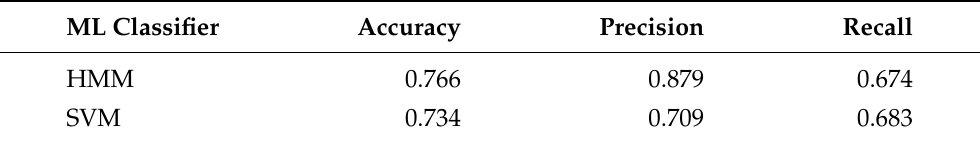
Table 3. Results of the inattention detection experiments in terms of three evaluation measures, accuracy, precision, and recall.